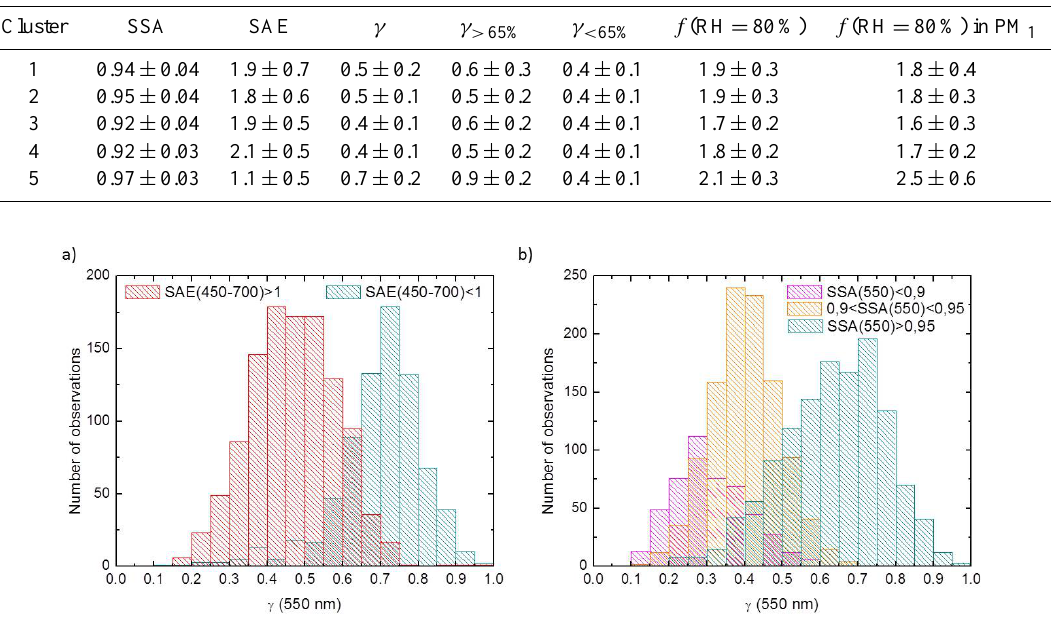
Figure 7. Frequency distribution of the γ parameter for different scattering Ångström exponent (a) and single scattering albedo (b) ranges Figure 7 . Frequency distribution of the γ p arameter for different scattering Ångström 3 in the PM 10 size exponent (a) and single scattering albedo (b) ranges in the PM 10 size fraction. 4